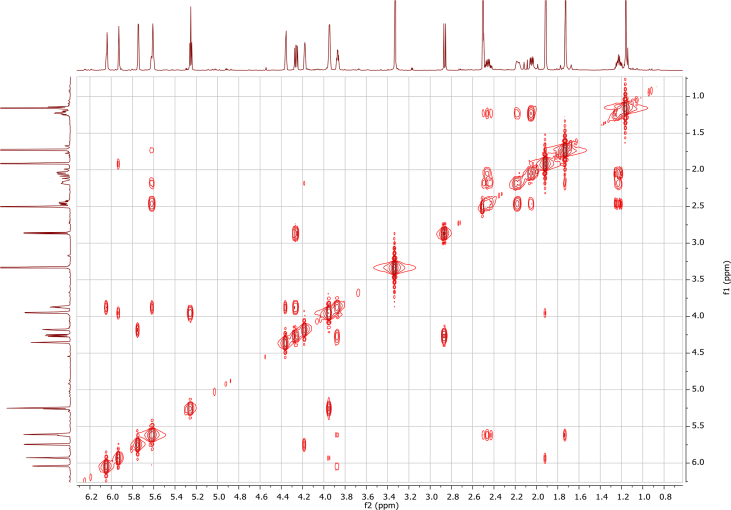
HH-COSY (DMSO-d6) spectrum of compound 5.